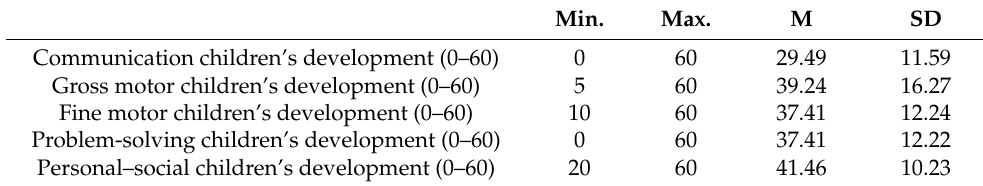
Table 1. Descriptive data on children’s development ASQ-3 scores.